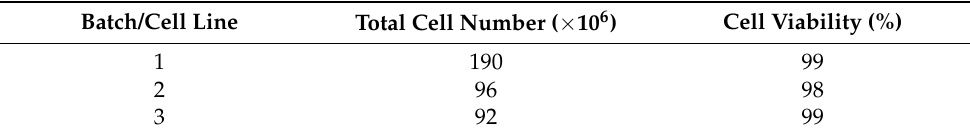
Table 7. Lyosecretome batch